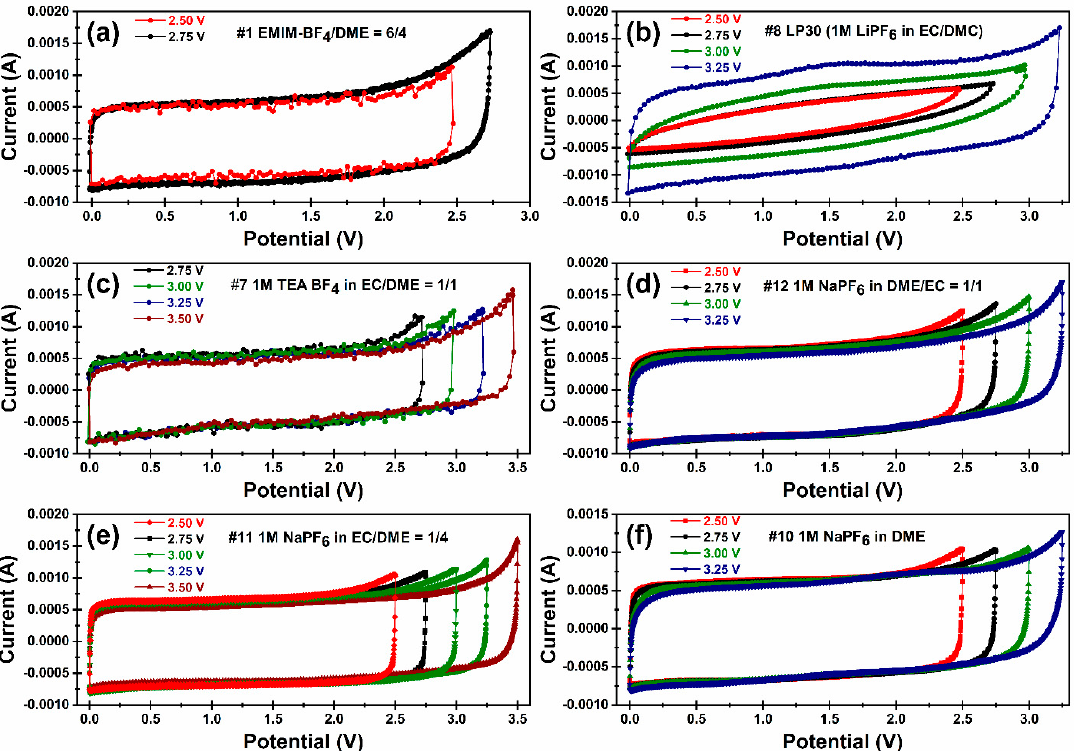
Figure 3. Cycling voltammetry curves of EDLC cells with formulations ( a ) #1, EMIM–BF 4 /DME = 6/4 v/v; ( b ) #8, LP30 (1 M LiPF 6 in EC/DMC = 1/1 v/v); ( c ) #7, 1 M TEA–BF 4 in EC/DME = 1/1 v/v; ( d ) #12, 1 M NaPF 6 in EC/DME = 1/1 v/v; ( e ) #11, 1 M NaPF 6 in EC/DME = 1/4 v/v; ( f ) #10, 1 M NaPF 6 in DME.